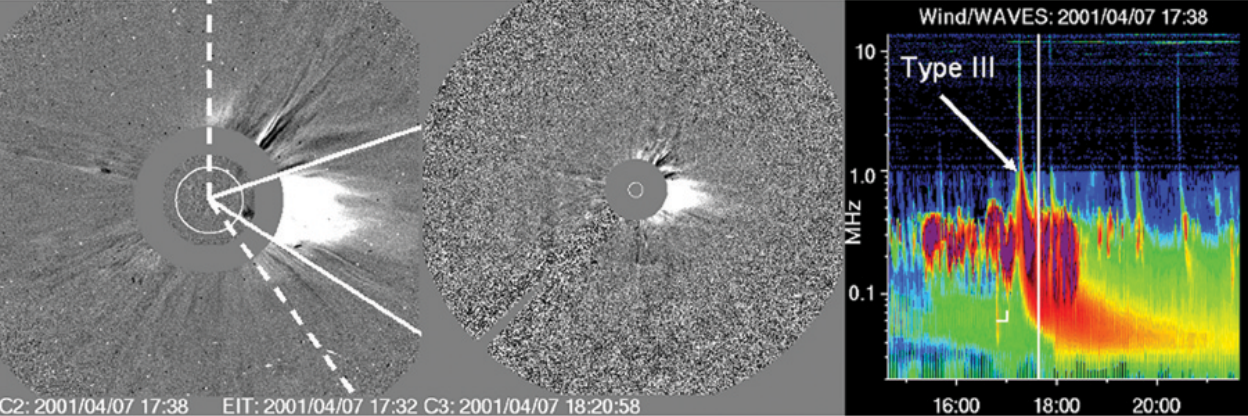
Fig. 5. SOHO/LASCO snapshots of the 7 April 2001 CME (the fastest RQ CME) at 17:38UT (C2 image) and 18:20UT (C3 image). The dashed lines (solid lines) show the CME edges of the overall disturbance (bright part) of the CME. The overall disturbance has a width of 152 ◦ , whereas the bright part has a width of only 80 ◦ . It is possible that the northern part of the CME is superposed with another weak CME. Wind/WAVES dynamic spectrum is shown on the right, with the type III burst indicated. There was no type II burst, so this CME is radio quiet.